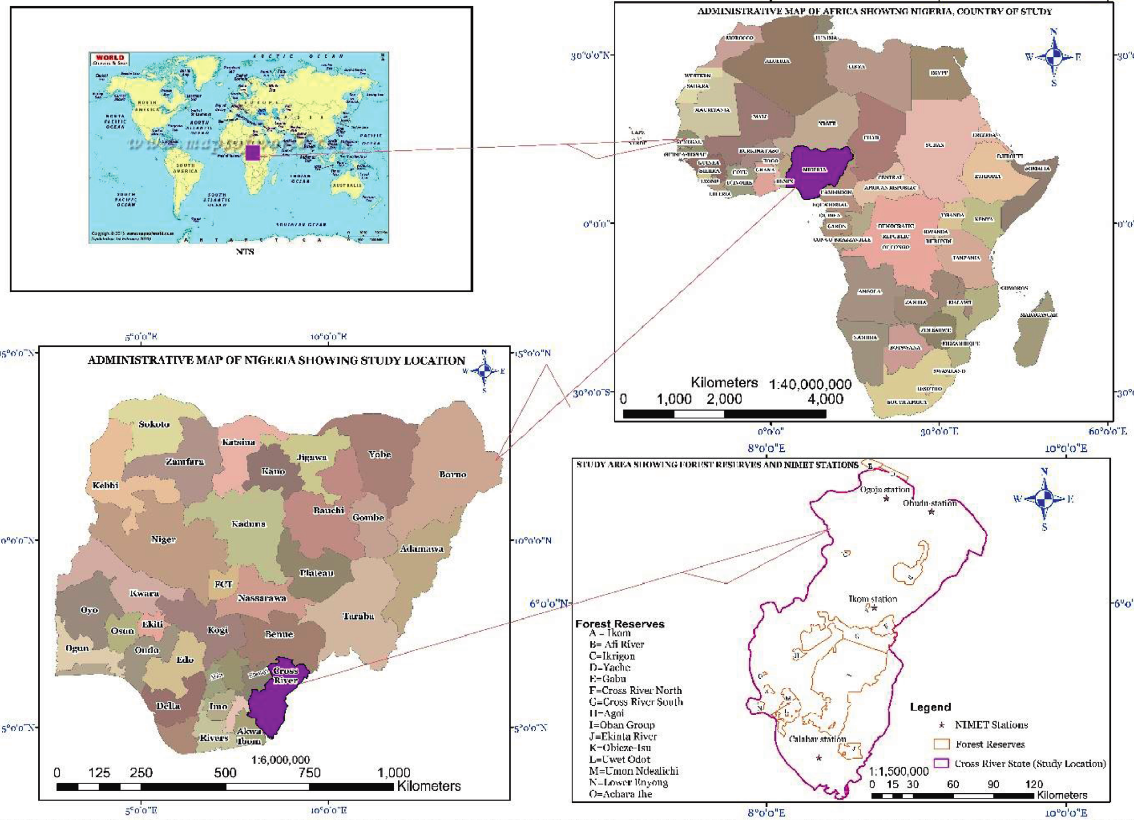
Figure 2: Representation of the location site used in the present research.